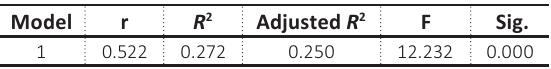
Table 10. Regressing intrapreneurship variable